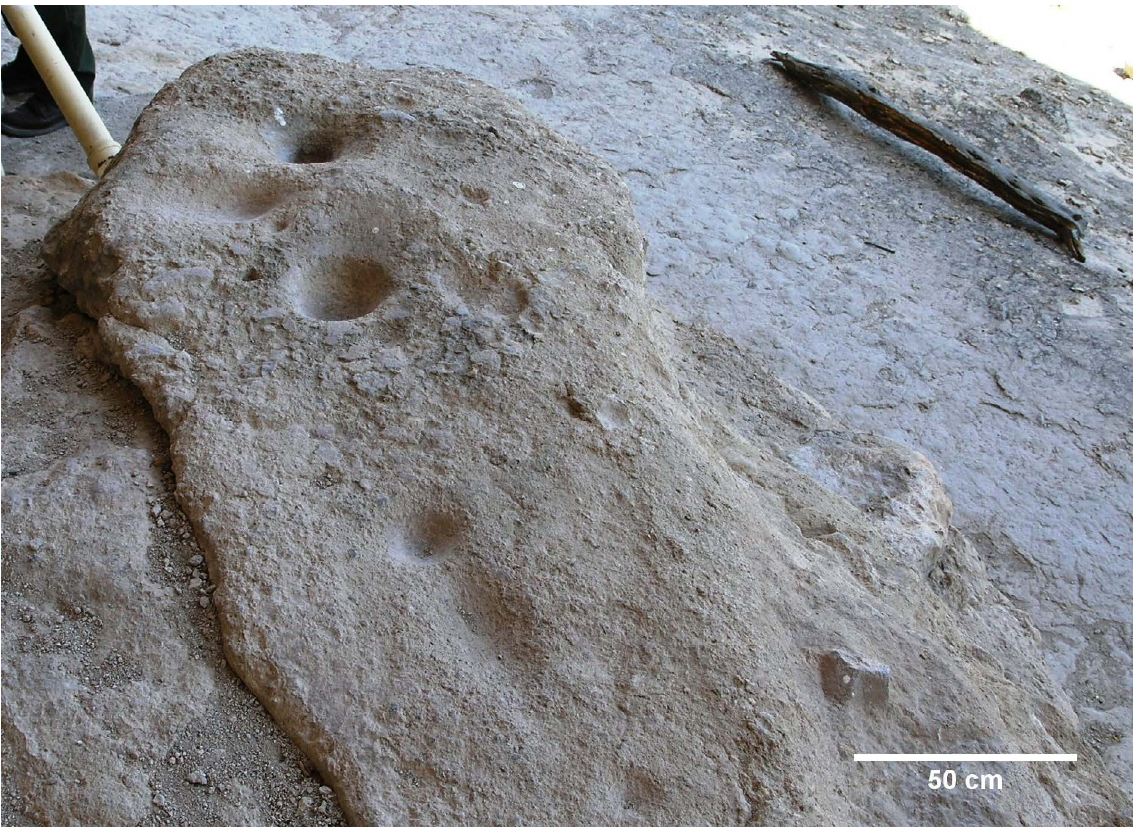
Figure 2. RMP-33 at Gila Cliff Dwellings National Monument, a sheltered bedrock outcrop with several mortars and grinding surfaces. Scale is